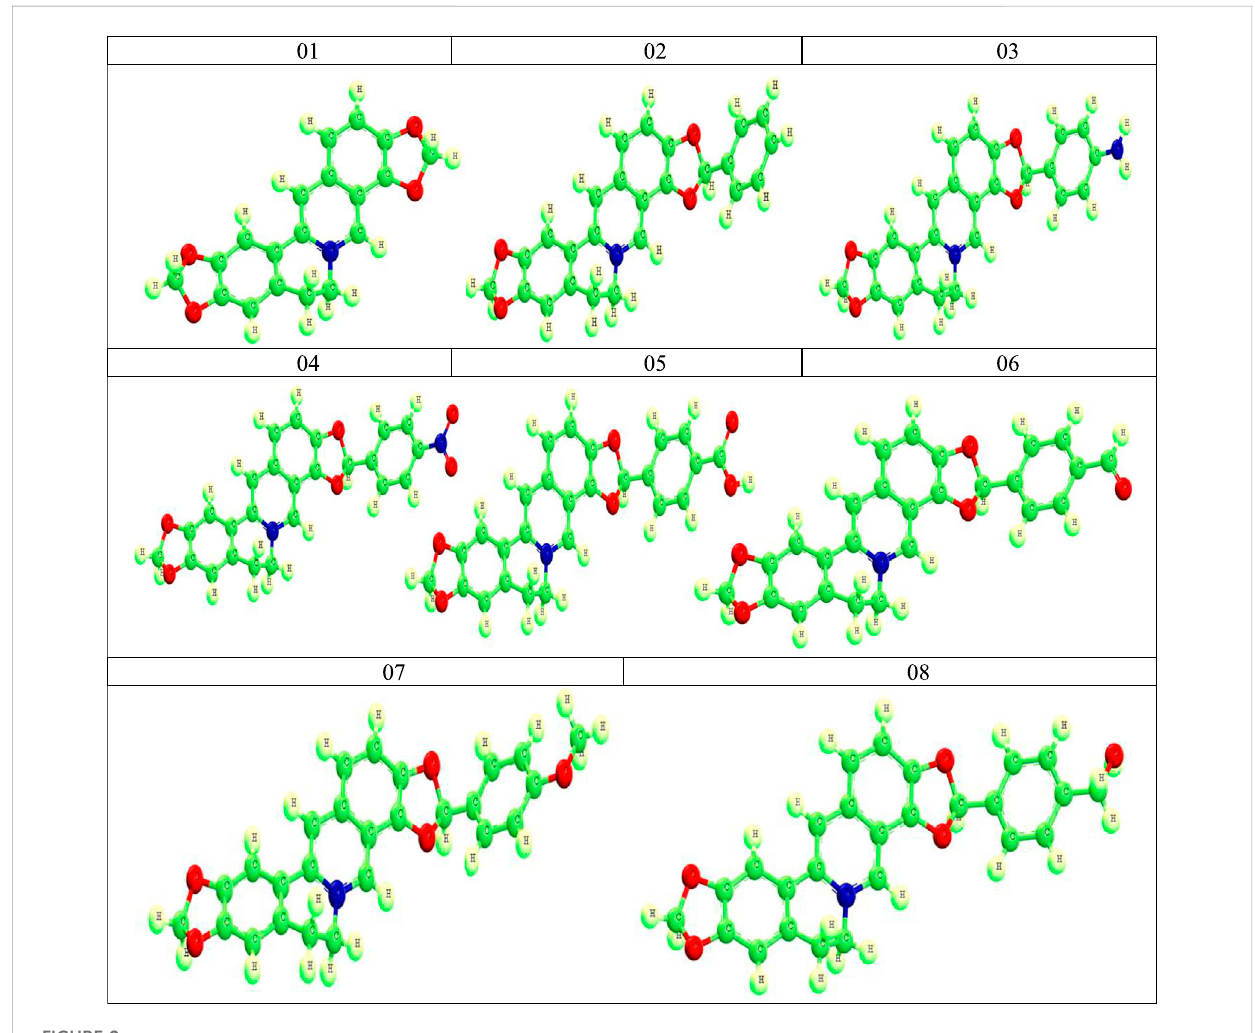
FIGURE 2 Optimized structures of Coptisine